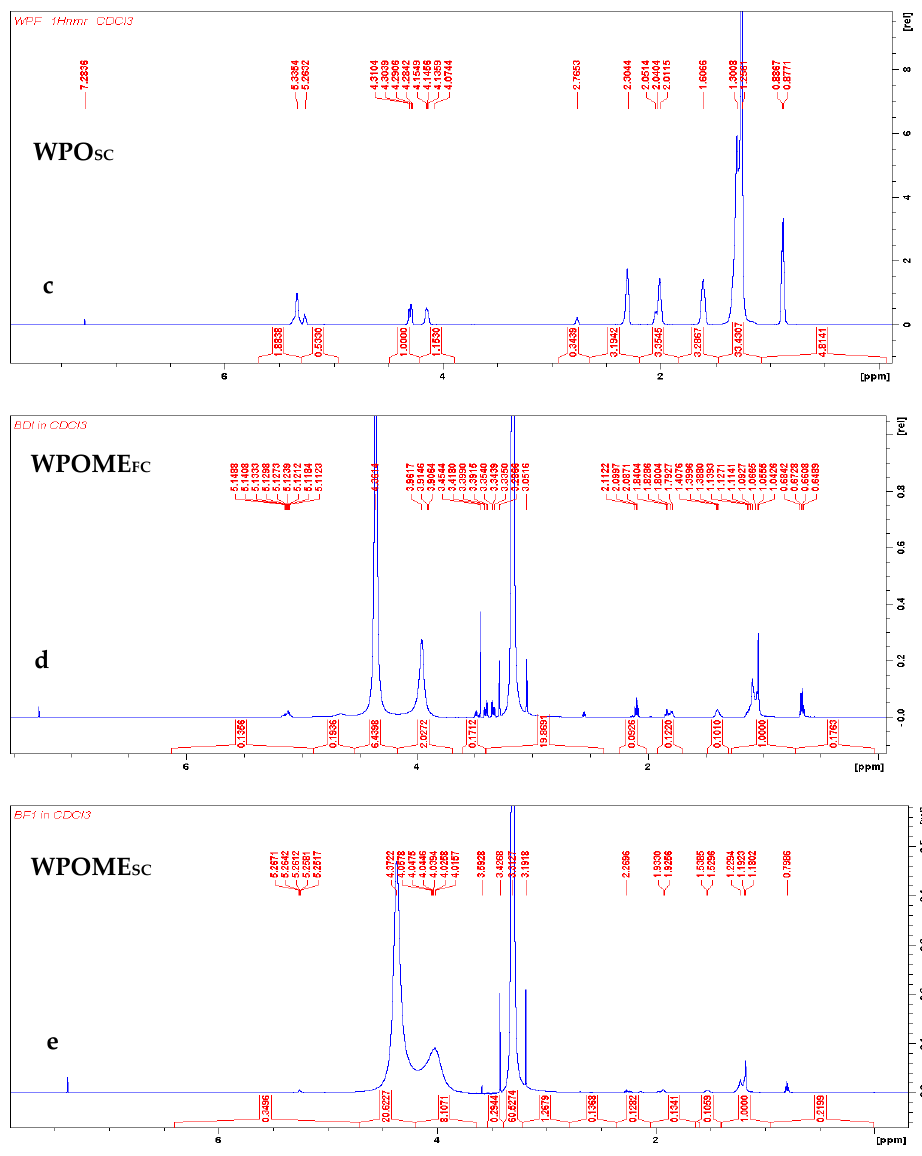
Figure 4. 1 H NMR spectrum for NPO, WPO and WPOME samples.